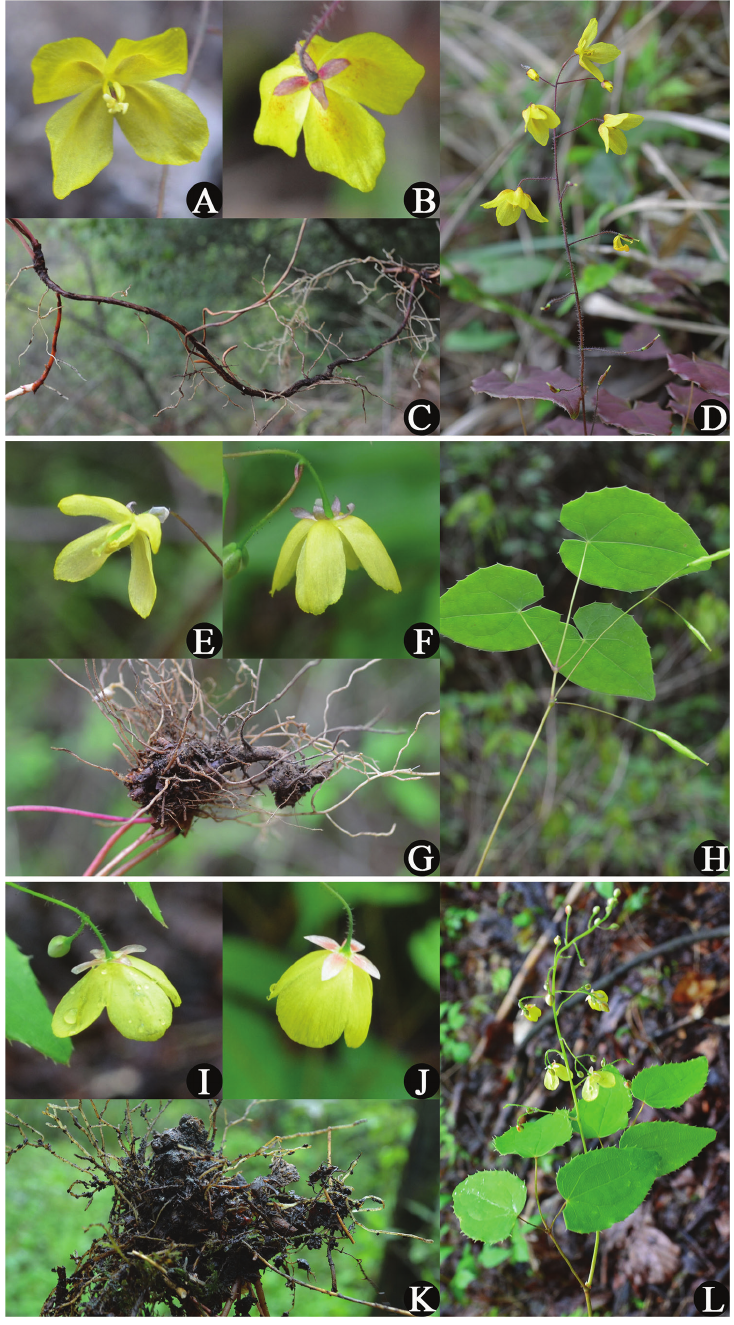
Figure 2. Photos of E. ecalcaratum , E. platypetalum , and E. campanulatum . A–B Flower of E. ecalcaratum C Rhizome of E. ecalcaratum D Morphology of E. ecalcaratum E–F Flower of E. platypetalum G Rhizome of E. platypetalum H Morphology of E. platypetalum I–J Flower of E. campanulatum K Rhizome of E. campanulatum L Morphology of E. campanulatum